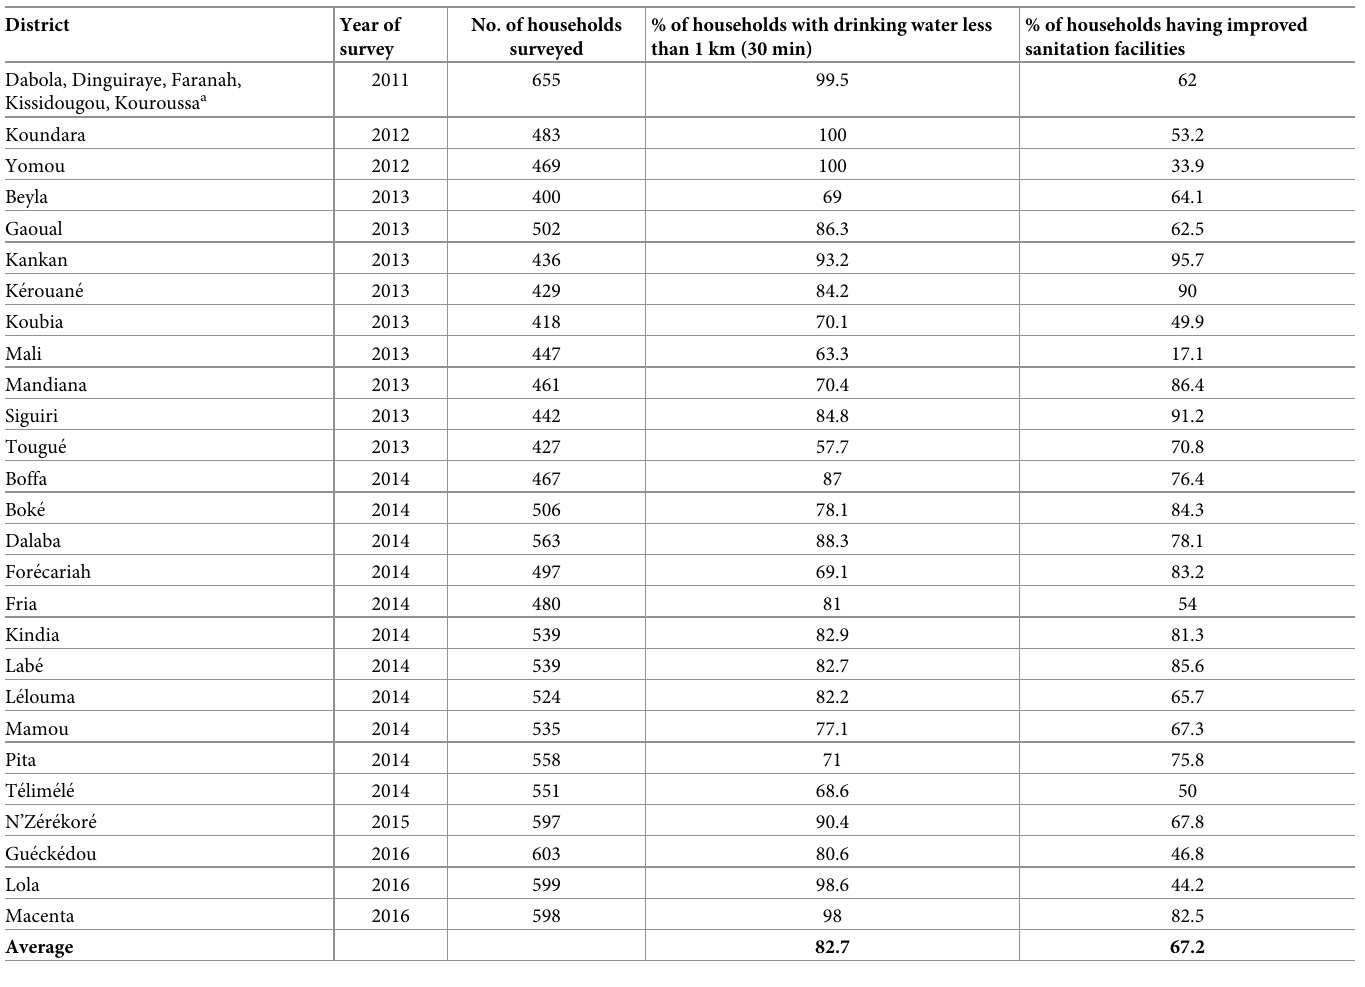
Table 3. Key indicators on access to water, sanitation and hygiene (WASH) by district in Guinea.